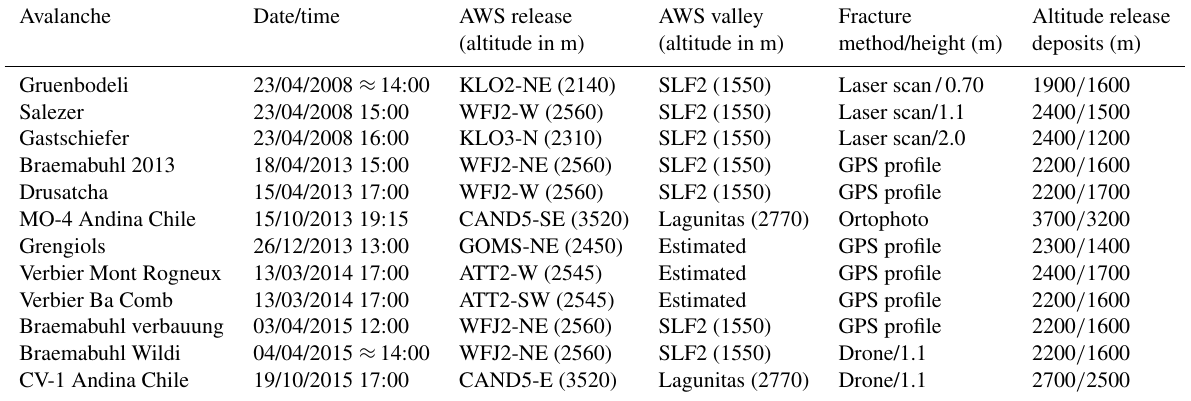
Table 1. List of case studies with date and estimated time of occurrence. The designation for the automatic weather station (AWS) in the release zone contains the nearest weather station followed by the exposition and altitude. The AWS at the bottom of the valley was used to characterize the deposit area. The column “Fracture” contains the method used to determine the location and height of the released snow mass. For the more accurate laser scan and drone measurements, the measured mean fracture heights are additionally